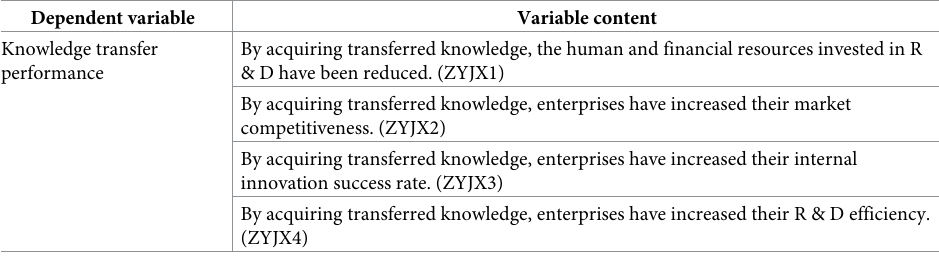
Table 5. Knowledge transfer performance measurement